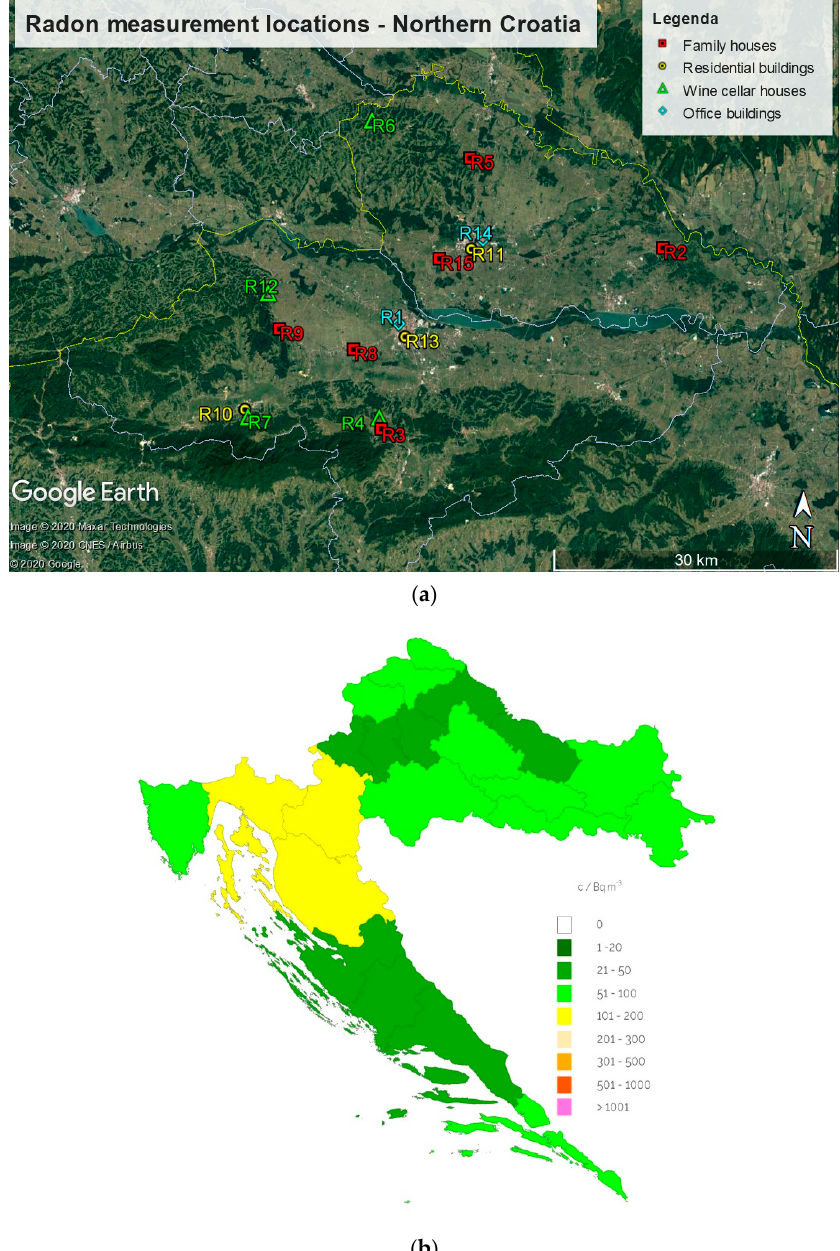
Figure 1. ( a ) Indoor radon measurement locations for randomly selected buildings in Northern Croatia. ( b ) National map of indoor radon levels in Croatia [5,13].